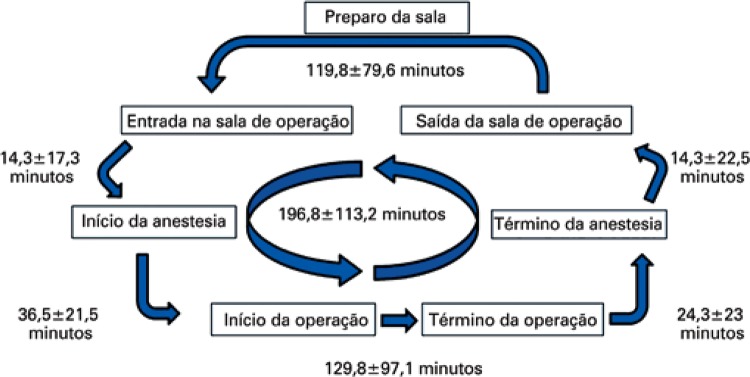
Esquema do processo na sala cirúrgica, indicadores de tempo com as médias e desvio padrão (em minutos)